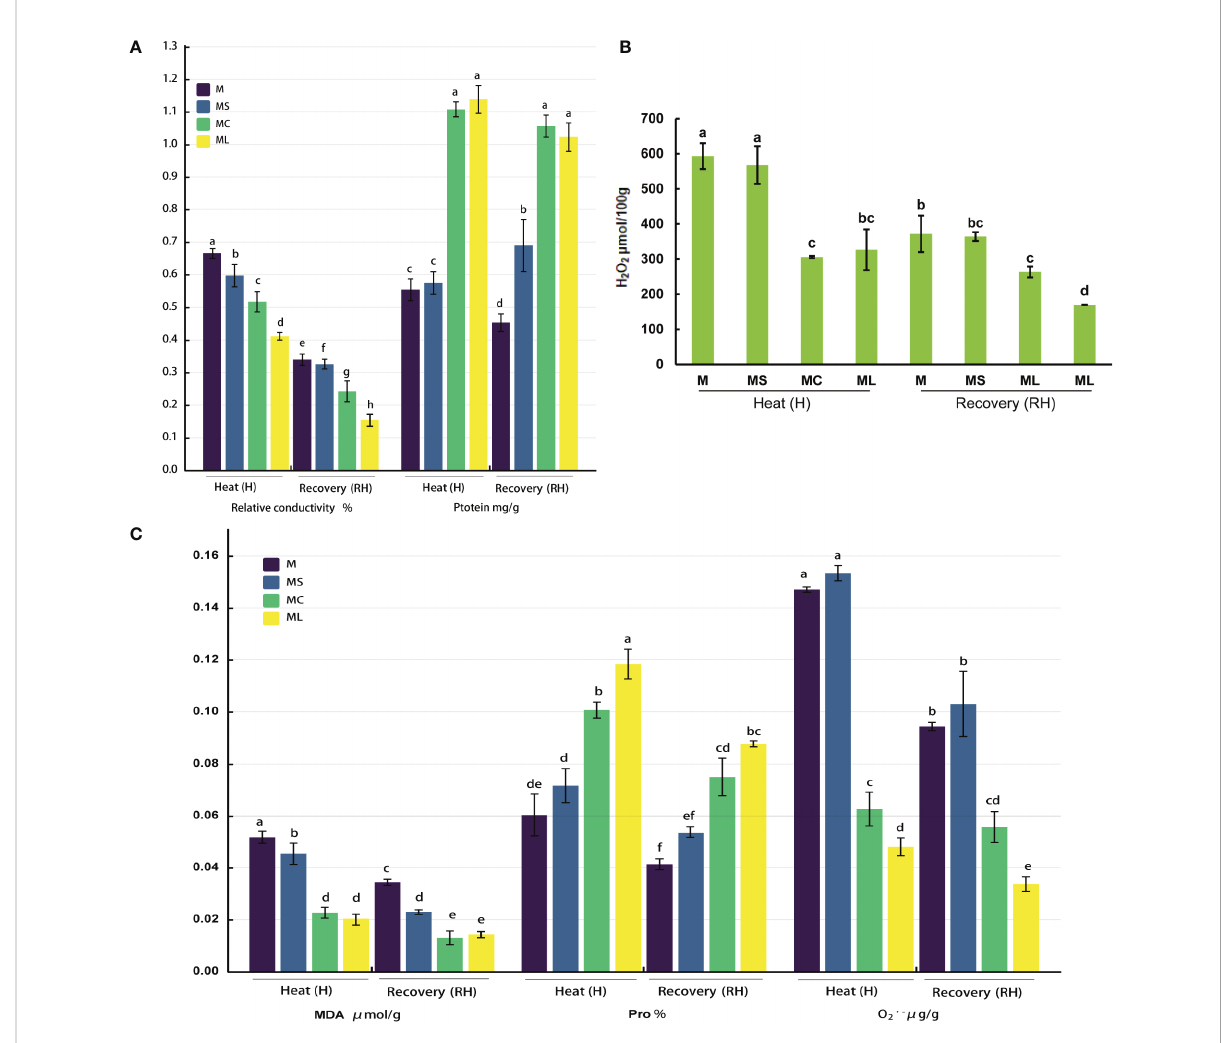
FIGURE 1 Changes in the ROS and osmotic substance levels. (A) Relative conductivity and protein content. (B) H 2 O 2 content. (C) MAD, Pro and O (cid:129) − 2 content. Values are the mean (± SE) of three replicates. Different letters indicate statistically signi fi cant differences between the treatment groups ( P<